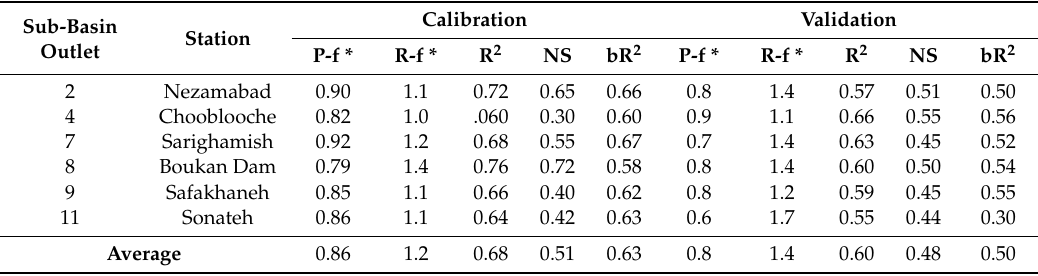
Table 3. Statistical measures for the SUFI-2-optimized objective functions for calibration and validation periods for various sub-basin outlet stations together with uncertainty measures (P- and R-factor).